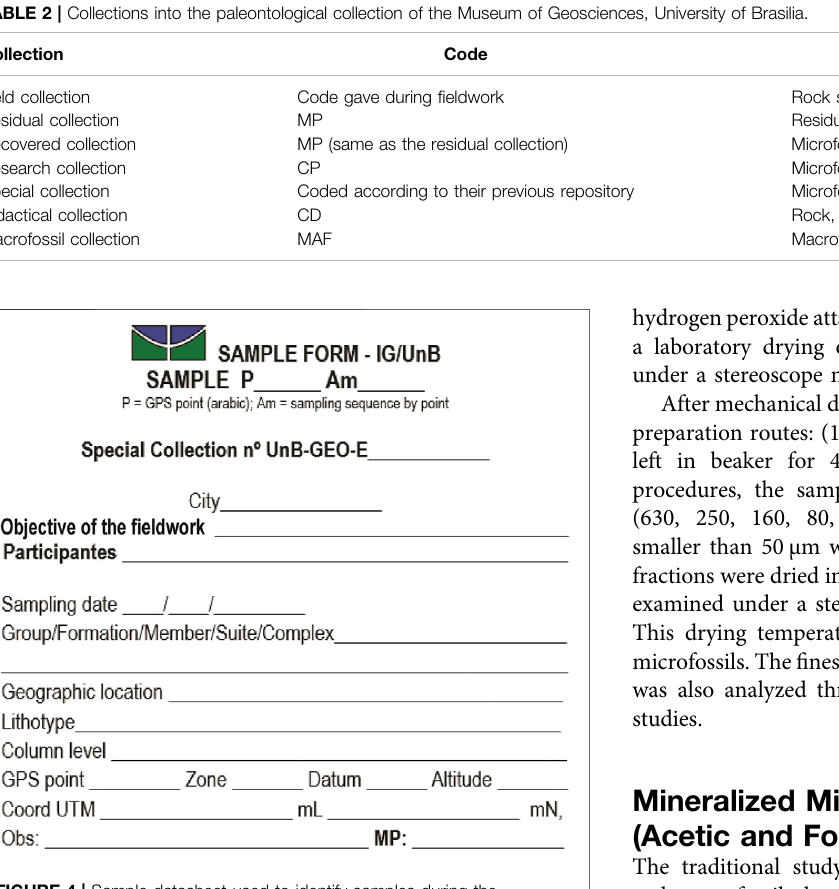
FIGURE 4 | Sample datasheet used to identify samples during the Laboratory of Micropaleontology fi eldwork, University of Brasília, Brazil. The datasheet contains all information needed for further